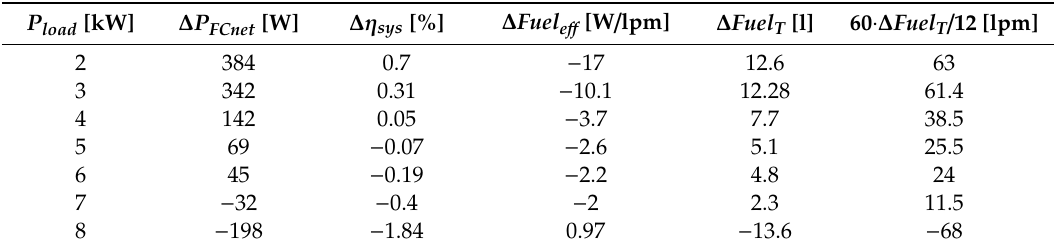
Table 1. The gaps in performance indicators for the Air-LFW and Fuel-LFW strategies ( P RES = 0). P load [kW] ∆ P FCnet [W]